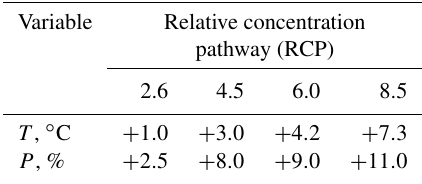
Table 1. Ensemble-averaged projections of air temperature ( ◦ C) and precipitation (%) anomalies for the XXI century in the Selenga river